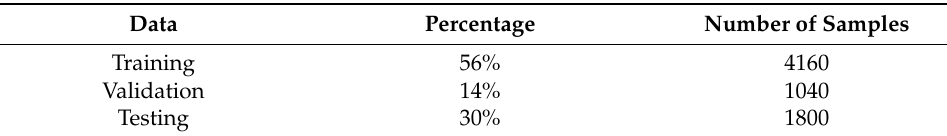
Table 3. Dataset split ratio for the S&R model.